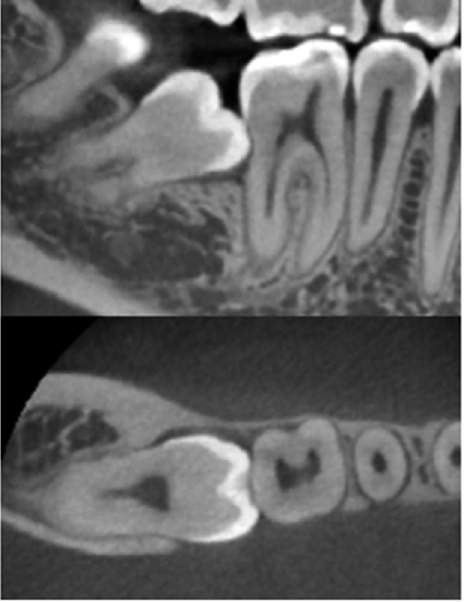
Figure 2. Three-dimensional computed tomography (3DCT)